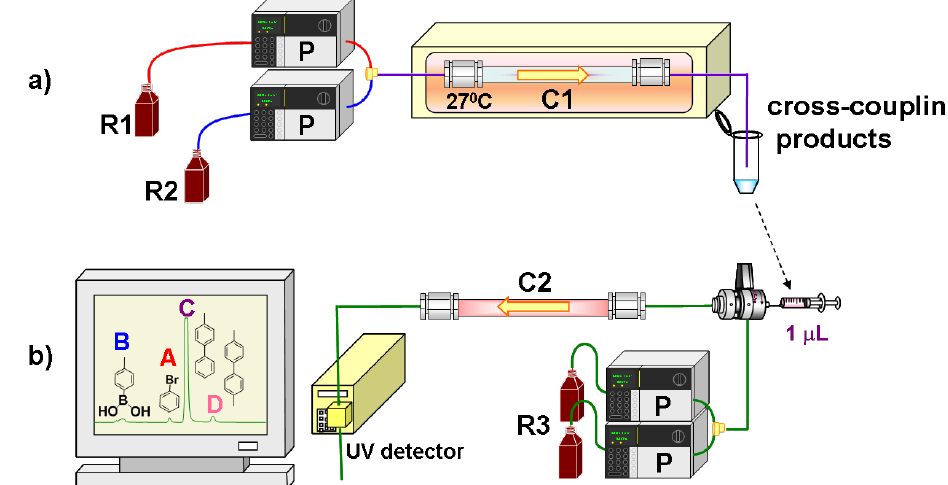
Figure 1. ( a ) Flow-through microreactor system for Suzuki–Miyaura cross-coupling reactions and ( b ) HPLC system for the analysis of cross-coupling products. R1: aryl–X, R2: 4-methyl boronic acid and Na 3 PO 4 , R3: acetonitrile/water (50:50 v/v ), P: HPLC pump, C1: monolithic microreactors M1 –